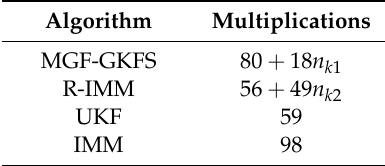
Table 3. Total number of multiplications.